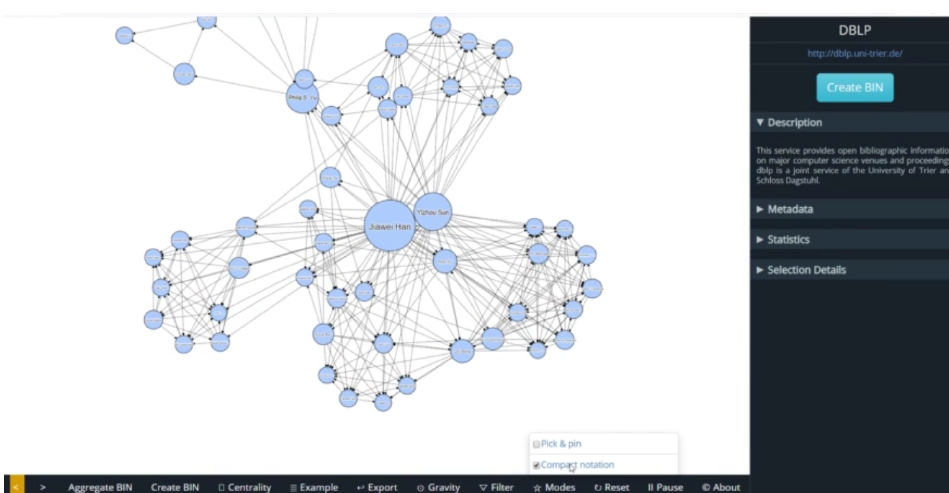
Figure 10. ’Author-Paper’ BIN created using GetConnotation